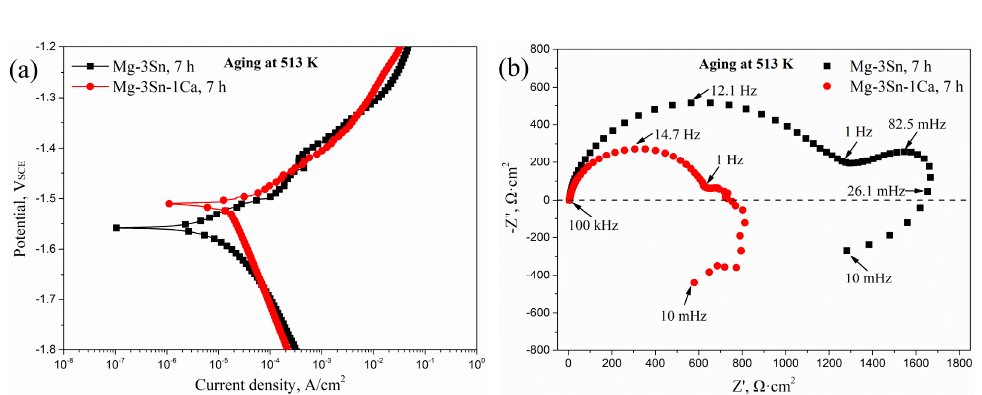
Figure 6. Potentiodynamic polarization curves ( a ) and Nyquist plot ( b ) of Mg-3Sn and Mg-3Sn-1Ca alloys for 7 h at 513 k.